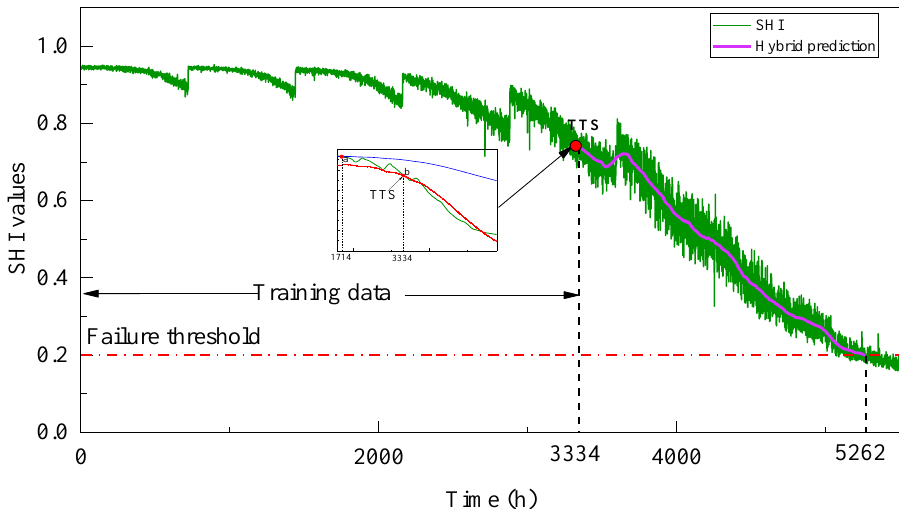
Figure 10. Hybrid prediction of system health condition.